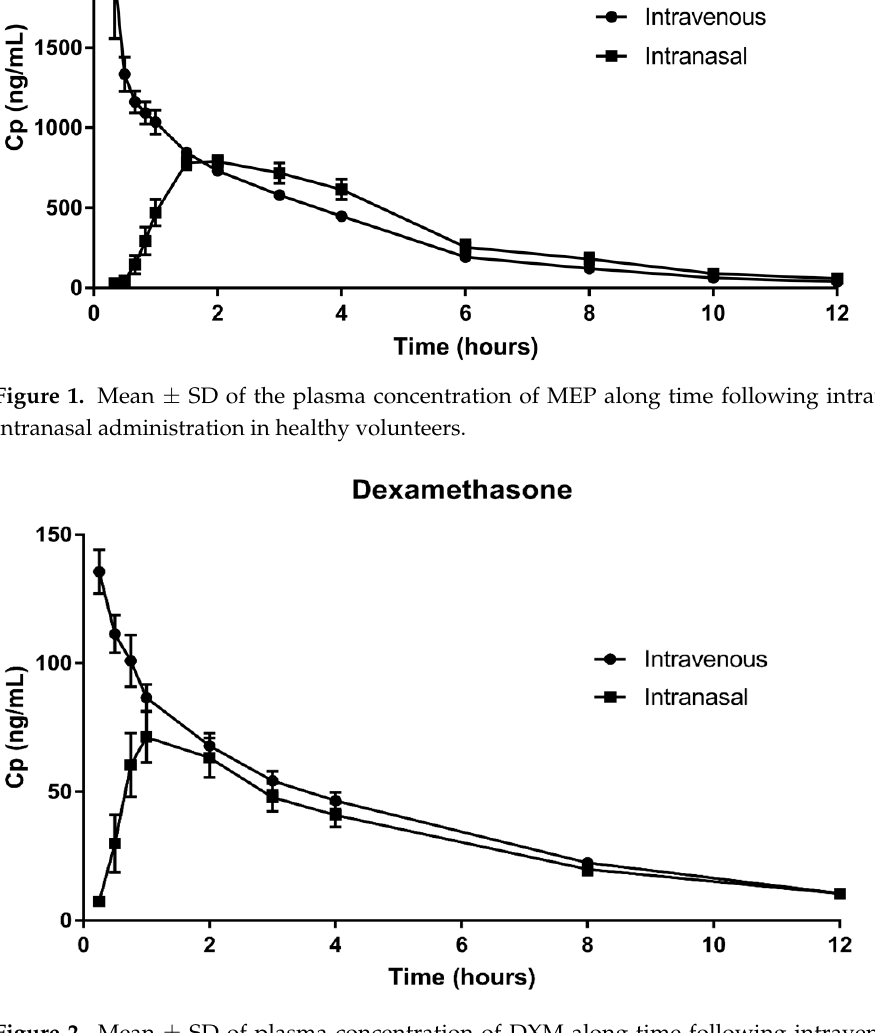
Figure 2. Mean ± SD of plasma concentration of DXM along time following intravenous or in- tranasal